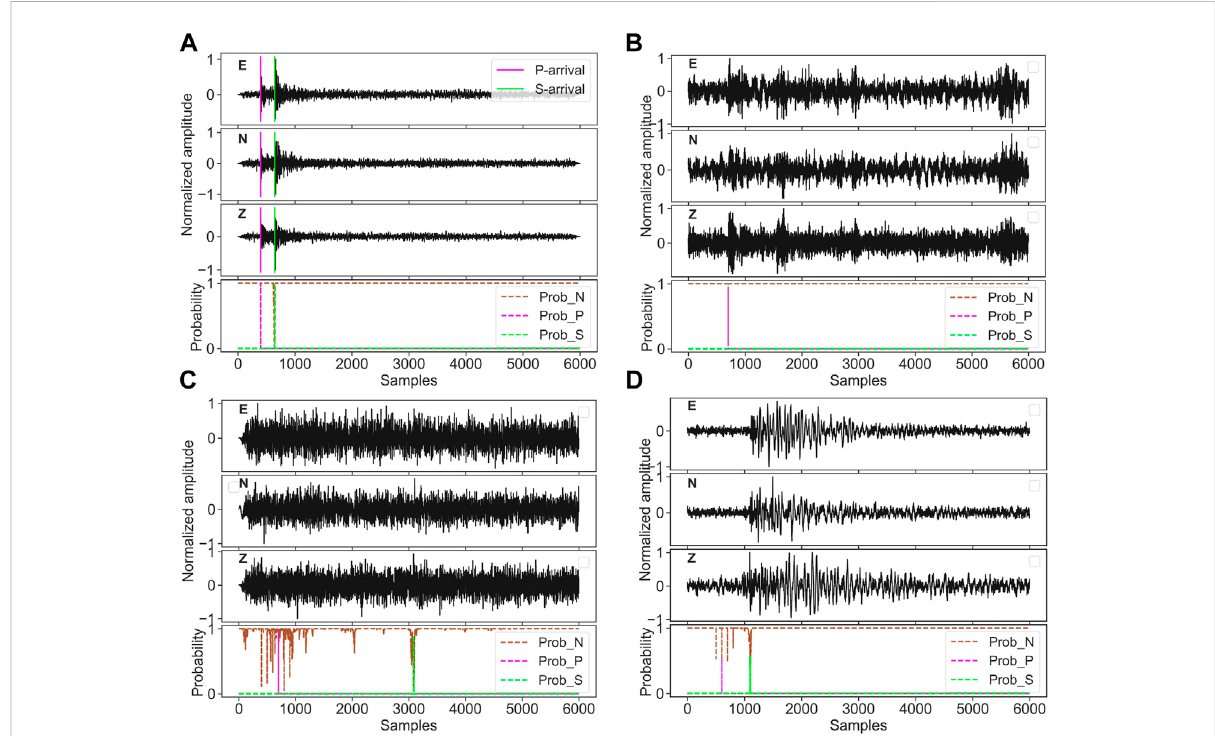
FIGURE 6 Visualization of a prediction example in the test dataset. (A) shows an earthquake waveform, correctly classi fi ed as an earthquake waveform. (B – D) show three misclassi fi ed examples, where the ground truth (according to the metadata) is non-earthquake, but the model classi fi es them as earthquake signals. In (B) , only the P-phase is detected, while in (C,D) , both P- and S-phases are detected. The fi rst three sub- fi gures represent the three-component seismic recordings, namely, “ E ” (east – west), “ N ” (north – south) and “ Z ” (vertical direction), respectively. The bottom sub- fi gureplotsthepredictedprobabilitycorrespondingtothethreeclasses: “ noise, ”“ Pwave, ” and “ Swave. ” Thetwocoloredverticallinesinthetopsub- fi gures of (A) denote the fi rst arrival times of P- and S-phases from the test dataset provided in the